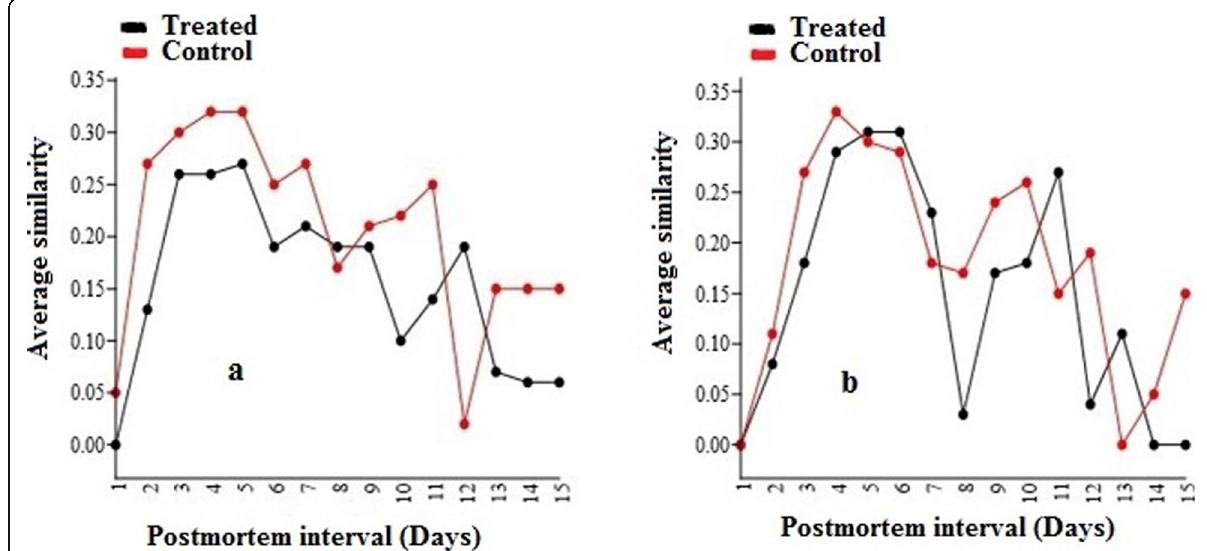
Fig. 3 Mean pairwise Jaccard similarities for each sampling interval during the succession of insect species on methadone-treated and untreated carcasses in the spring ( a ) and winter ( b )